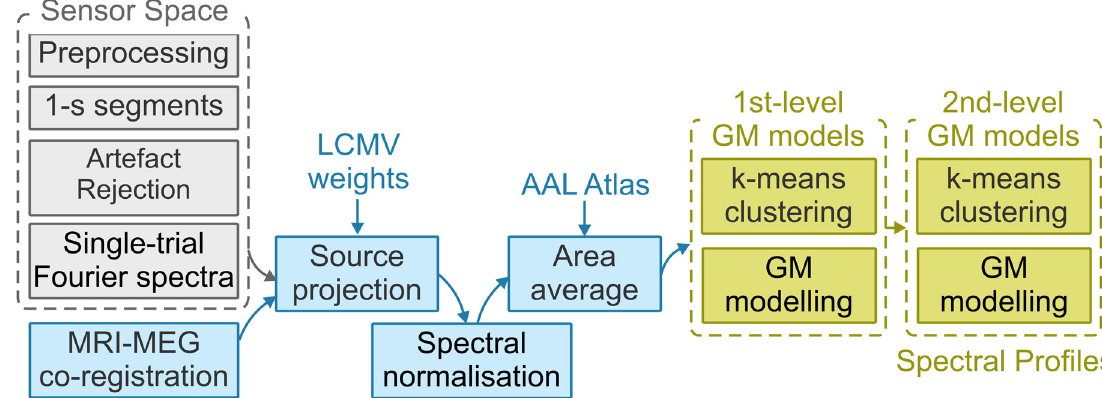
Fig 1. Analysis pipeline. After general preprocessing of the MEG data, the ~7-min continuous data were first segmented into 1-s segments. Artefactual segments and channels were rejected, and complex Fourier spectra were computed for each segment. Single trials (refers to 1-s segments) were then projected into source space by using previously computed linear constraint minimum variance (LCMV) weights. Data were spectrally normalised by dividing the spectrum of each segment and voxel by the average power spectrum across all segments and voxels per participant (ratio normalisation). Voxels were grouped according to the Automated Anatomical Labeling (AAL) atlas and activity averaged for each area. k -means and Gaussian mixture (GM) modelling algorithms were applied to reduce the dimensionality of trials for each participant (1st-level models, subject level) into ten distinct clusters. These ten clusters were clustered across all 22 participants, again using k -means and GM modelling algorithms (2nd-level models, group level). For 2nd-level models, the optimal number of clusters per area was computed, using a Silhouette criterion. Second-level GM models are referred to as spectral profiles or fingerprints.